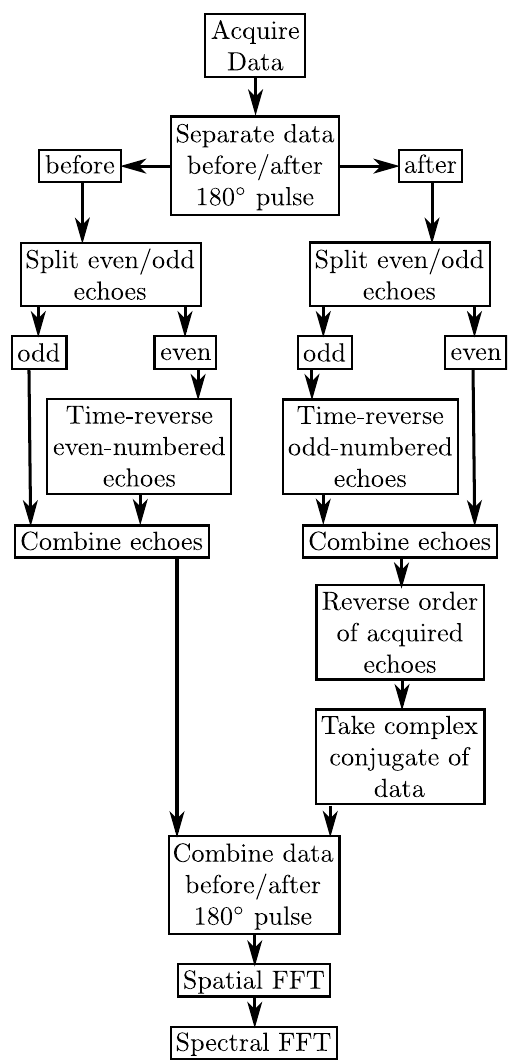
Flowchart showing how to separate and process the different echoes in the MEEPSI sequence as shown in Figure